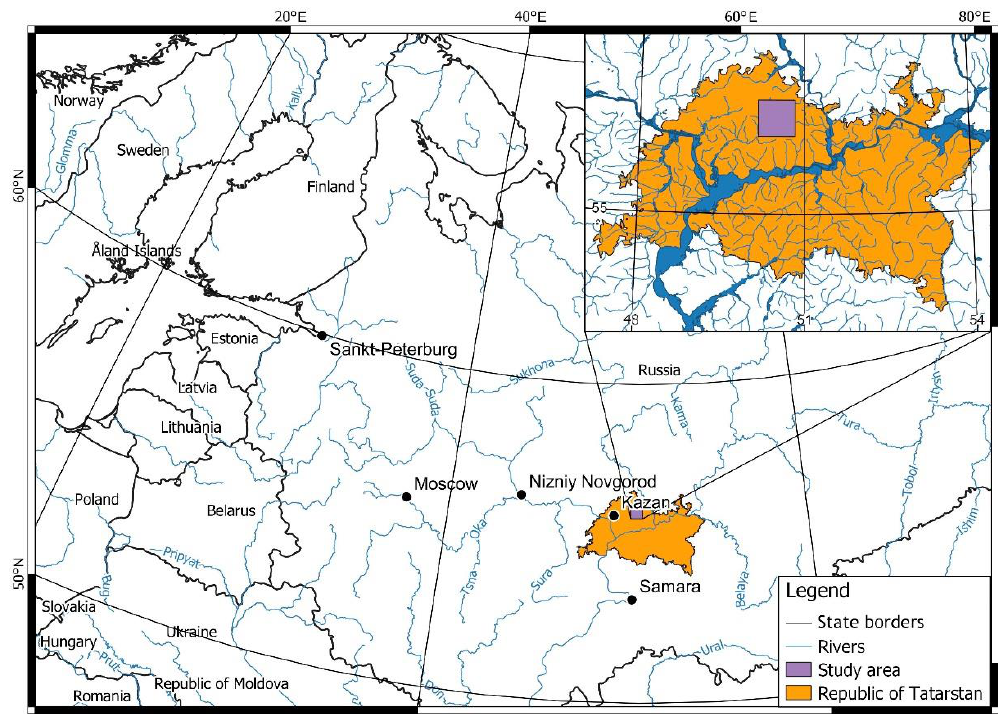
Figure 1. Study area.